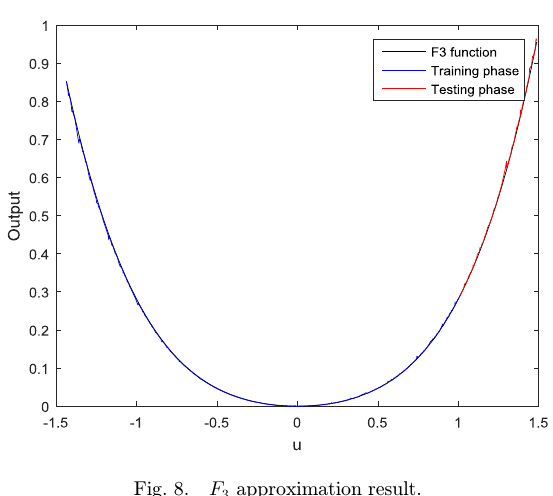
Fig. 8. F 3 approximation result.